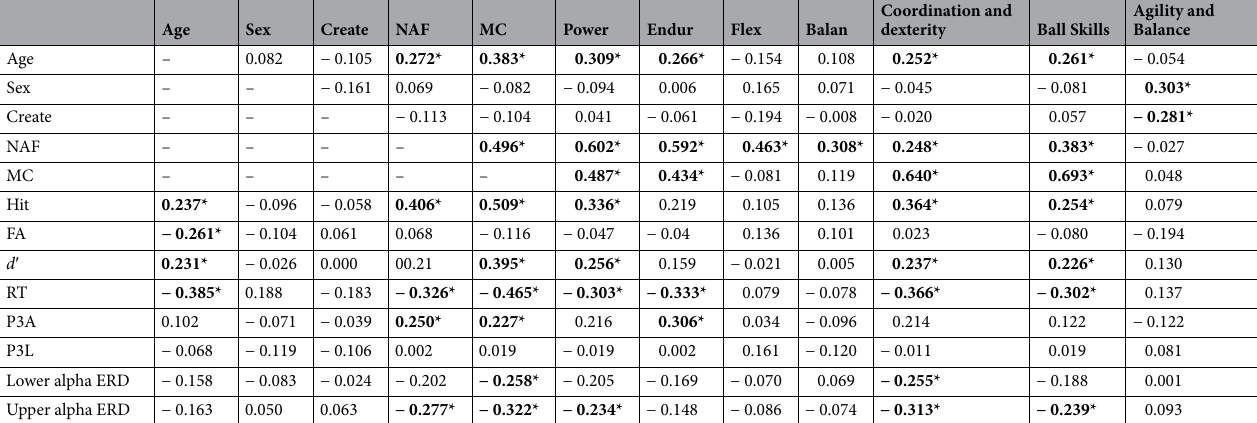
Table 2. The correlation matrix showing correlations ( r coefficients) of demographic variables with non- aerobic fitness, motor competence, and the behavioral and neuroelectric outcomes. Bold values with a * denote significant correlation at p < 0.05. Create = creativity. NAF = non-aerobic fitness. MC = motor competence. Power = muscular power. Endur = muscular endurance, Flex = flexibility, Balan = Balance. P3A = P3 amplitude. P3L = P3 latency.